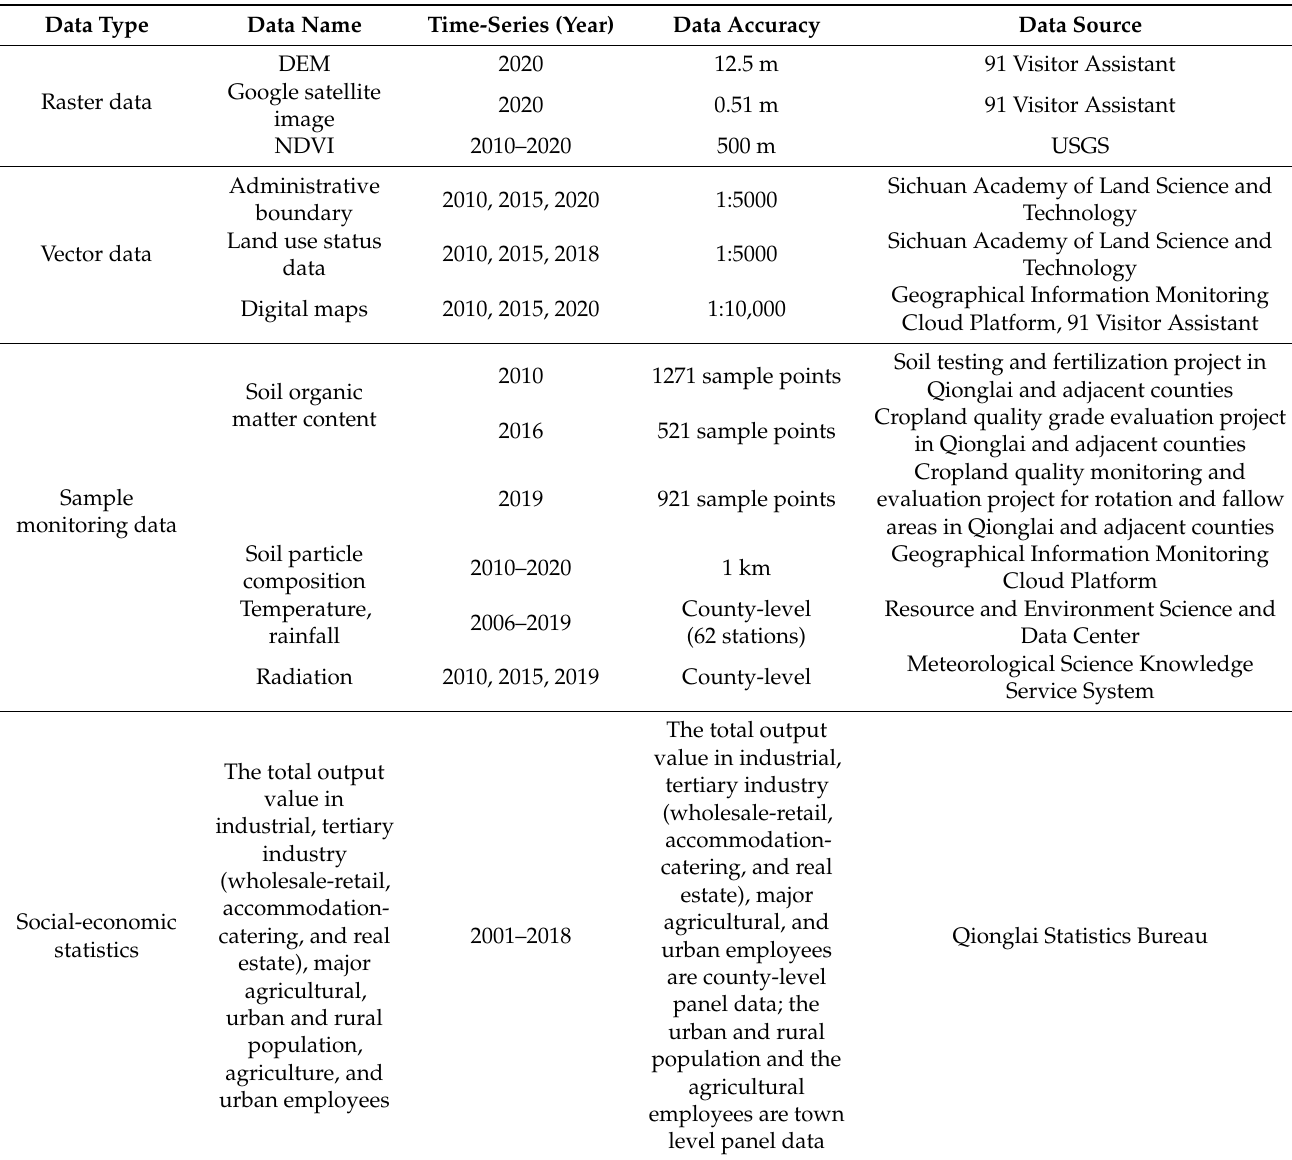
Table 1. Data sources and